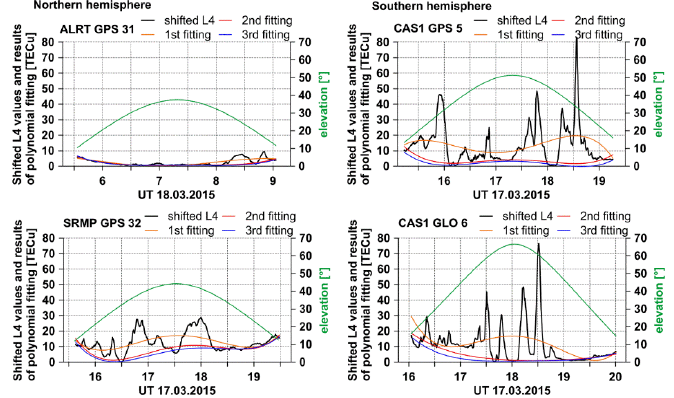
Figure 1. Background slant total electron content (STEC) estimation using iterative polynomial fitting.